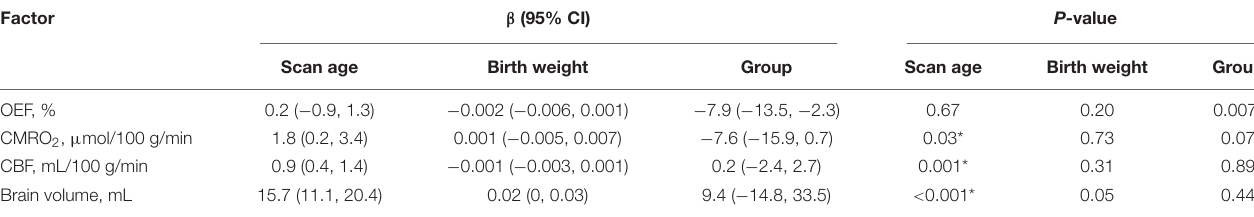
TABLE 2 | Association between maternal PIH (PIH and non-PIH group) and measured physiological parameters ( N = 38). Factor β (95% CI) P -value Scan age Birth weight Group Group